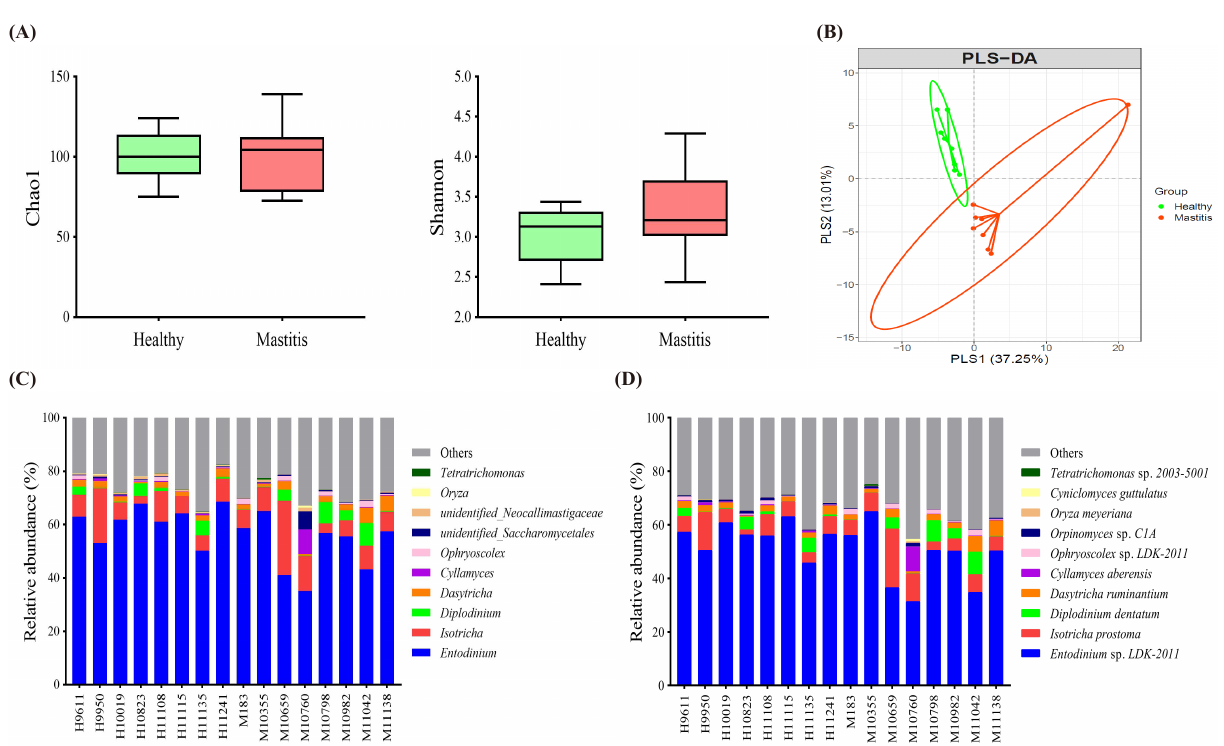
Figure 3. Ruminal protozoa and fungi composition were identified by 18S rRNA sequencing. ( A ) The Chao1 richness estimator and Shannon’s diversity index. ( B ) Partial least squares discriminant analysis (PLS-DA) plot based on the relative abundance of OTUs indicates a significantly different composition of healthy versus mastitis groups. Ellipses represent 95% confidence intervals for each group. The top 10 ( C ) genera and ( D ) species identified in cow ruminal fluid, each bar refers to an individual